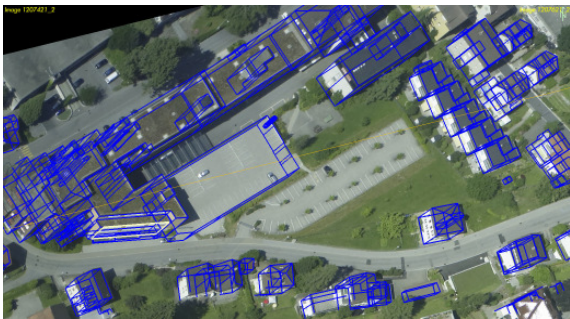
Figure 7: Quality check by superimposition of 3D building models into original oblique